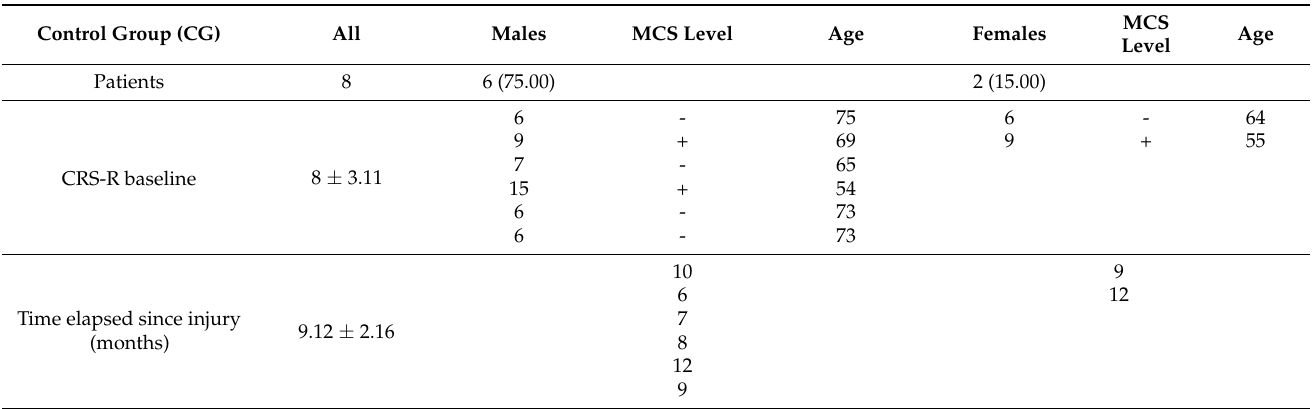
Table 1. Demographic and Clinical